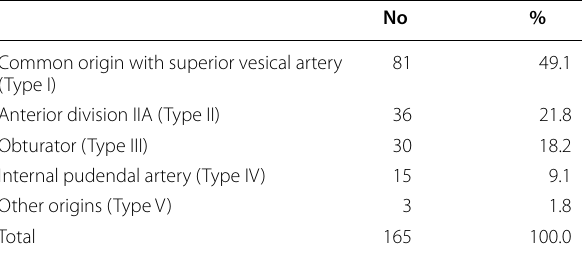
Table 2 Percentage of each origin for prostatic artery in our